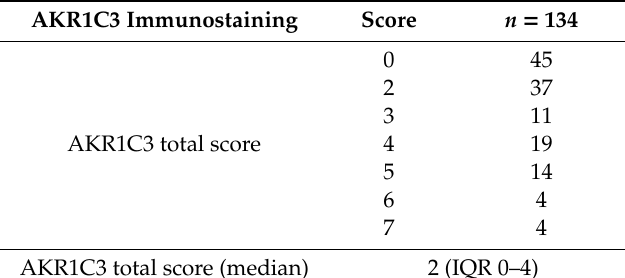
Table 2. AKR1C3) total score distribution of TMA specimens.